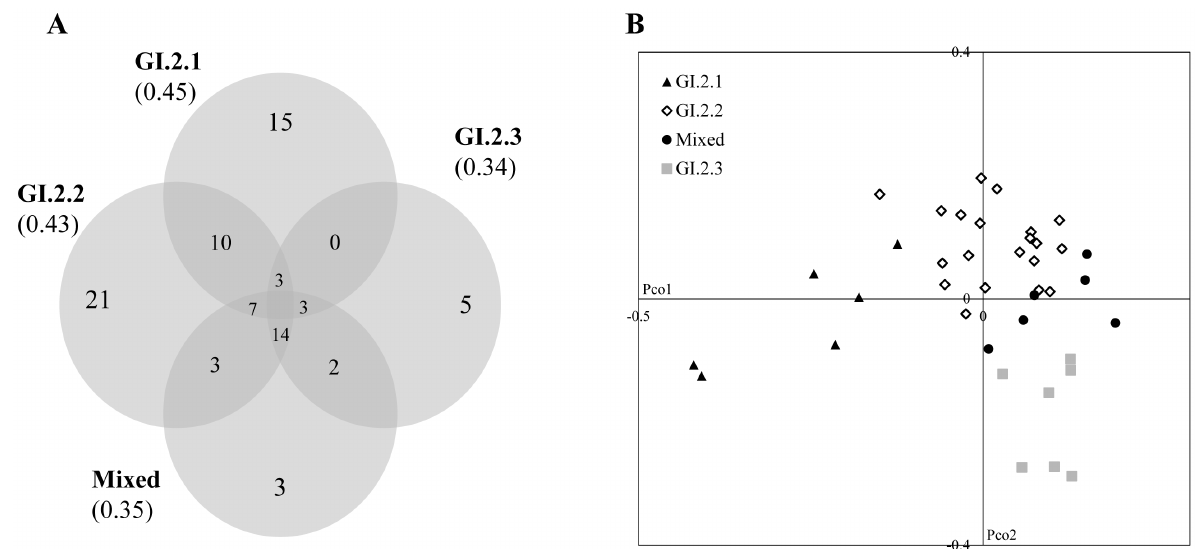
Fig. 4. Venn diagrams and Principal Coordinate Analysis (PCoA) on the Spanish C. annuum groups established after structure analysis. A) Diagrams showing the number of unique alleles and shared alleles in the four groups defined by STRUCTURE in the Spanish C. annuum landraces. B) PCoA of the Spanish C. annuum accessions represented according to their memberships coefficients for K 5